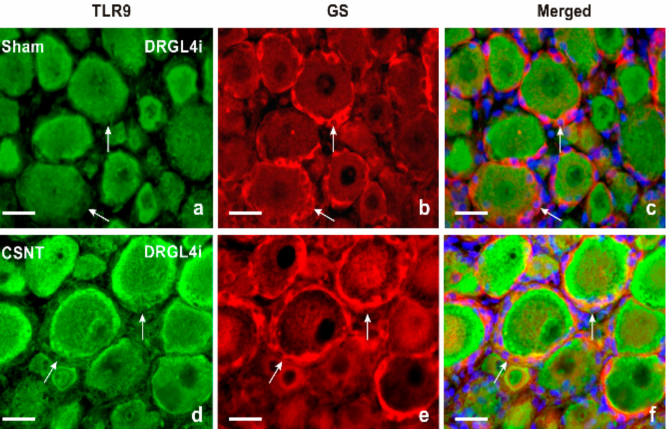
Figure 2. Double immunofluorescence staining for TLR9 and GS as a marker of satellite glial cells (SGCs). Sections of lumbar DRG ipsilateral (DRGL4i) to sham operation (Sham) and CSNT were immunostained with a mixture of rabbit polyclonal anti-TLR9 ( a , d ) and mouse monoclonal anti-GS ( b , e ) antibodies. Immunostaining was visualized with TRITC-conjugated donkey anti-rabbit and FITC-conjugated donkey anti-mouse secondary antibodies. Cell nuclei were detected with Hoechst 33342. Merged pictures ( c , f ) show no TLR9 immunostaining in SGCs of DRG from sham-operated rat (arrows in Figure 2c), while SGCs enveloping large-sized neuronal bodies in DRG from CSNT- operated rat displayed clear TLR9 immunofluorescence (arrows in Figure 2f). Scale bars = 20 µ m.